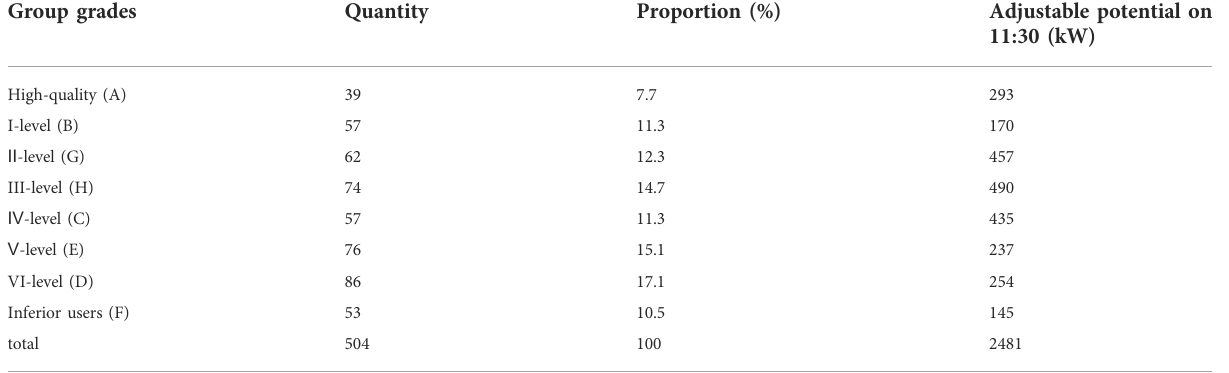
TABLE 7 Statistics of clustering results.